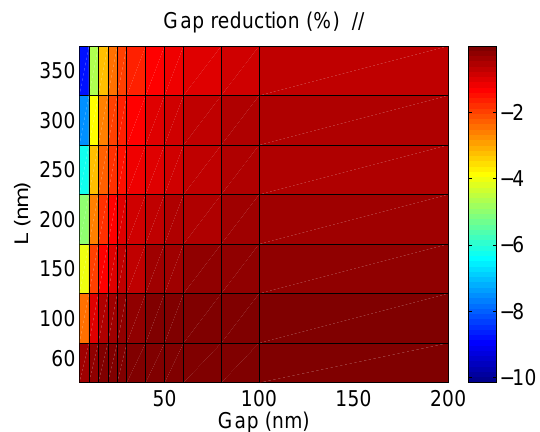
Figure 15: Ratio of the mean value of Q for the sphere and the cylinder: Q 3 D /Q 2 D as a function of the radius of the